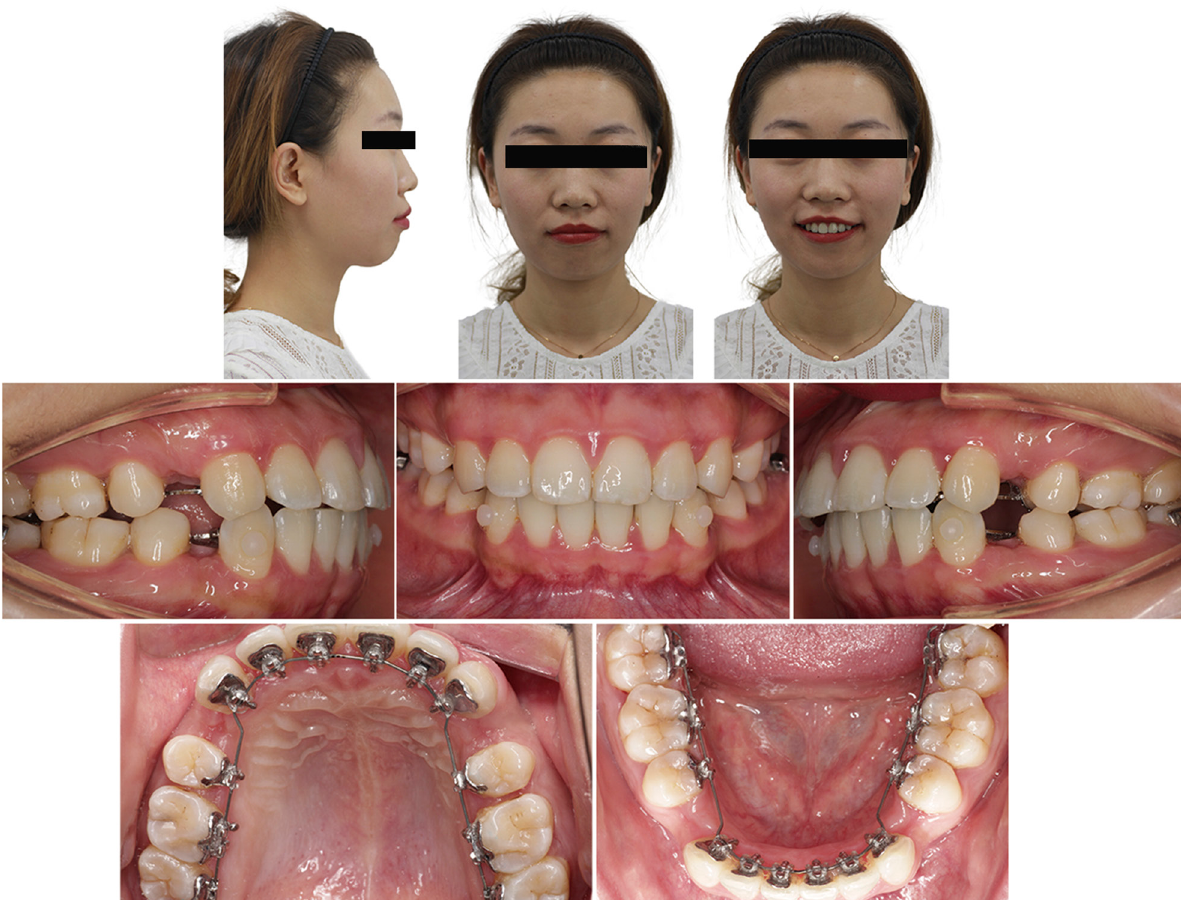
Figure 6. The maxillary and mandibular teeth were levelled and aligned in 4 months.